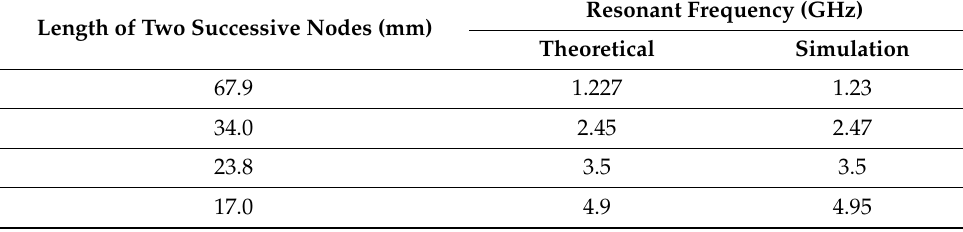
Figure 6. |S11| graph of the single unit meander line antenna.